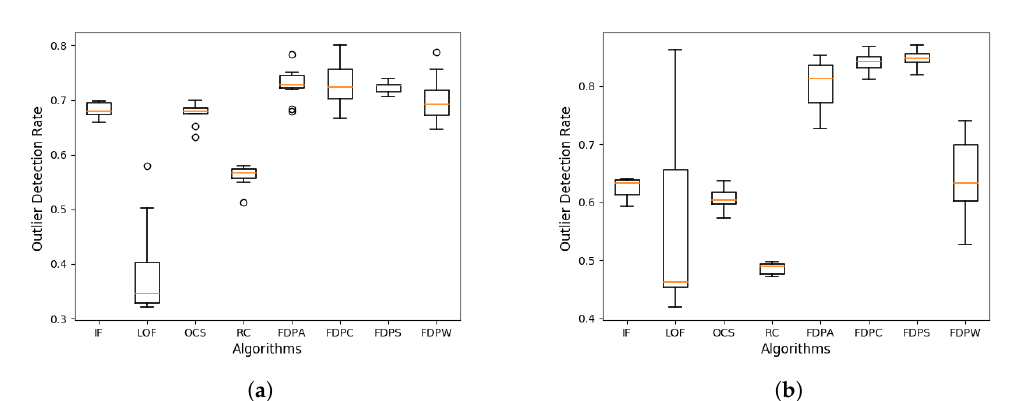
Figure 8. Box plots of the outlier detection rates for dataset series ( a ) D1 and ( b ) D2 with different sized